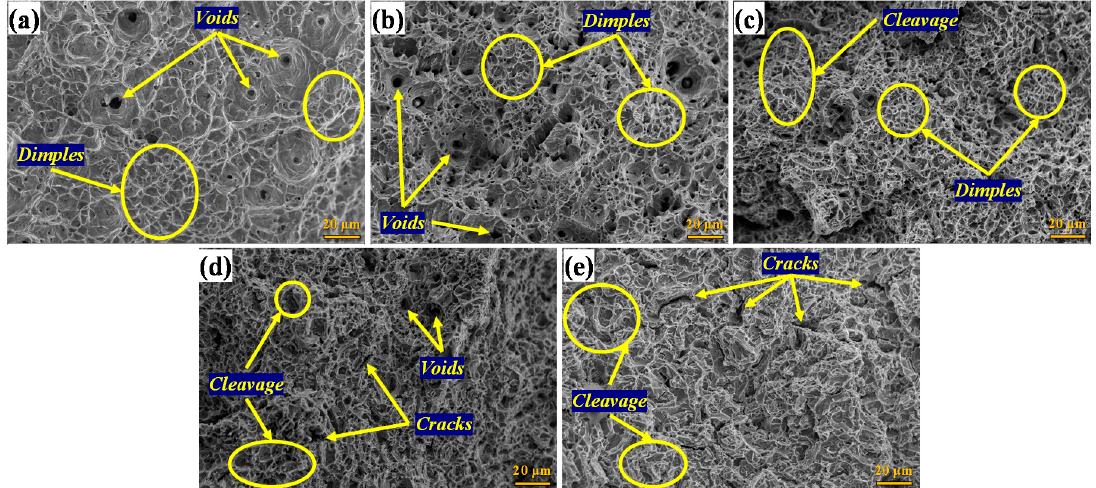
Figure 5. ( a – e ) SEM of fracture surfaces of the specimens (0–180 min,